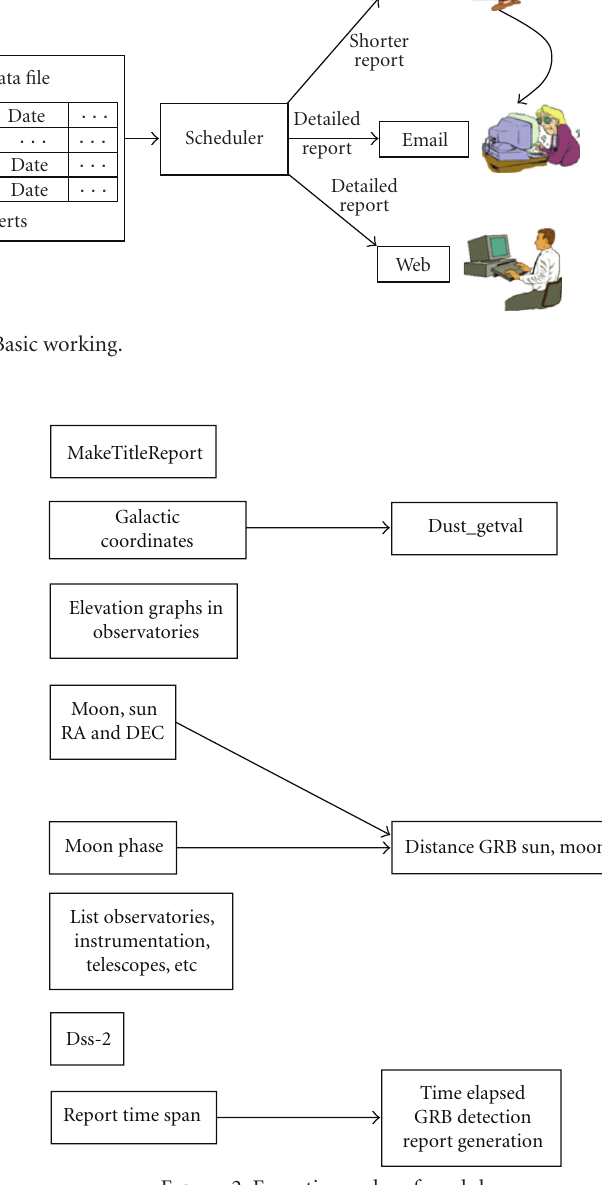
Figure 2: Execution order of